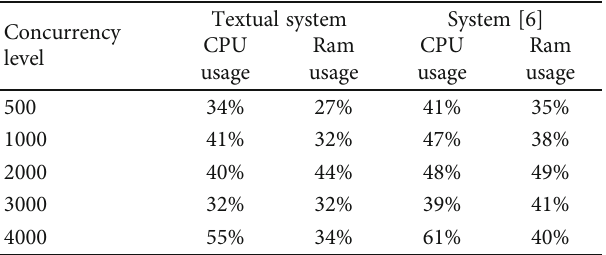
Table 1: System stability